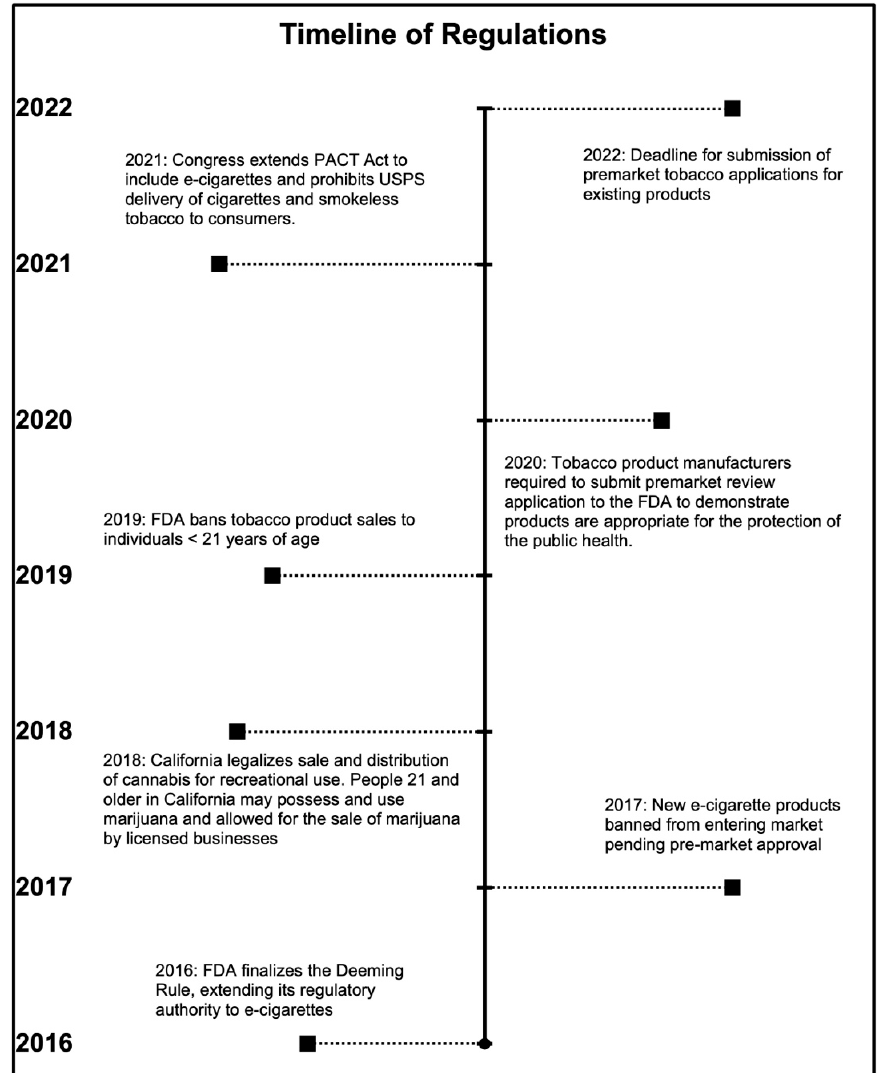
Figure 1. Timeline of Relevant State and FDA Regulations.